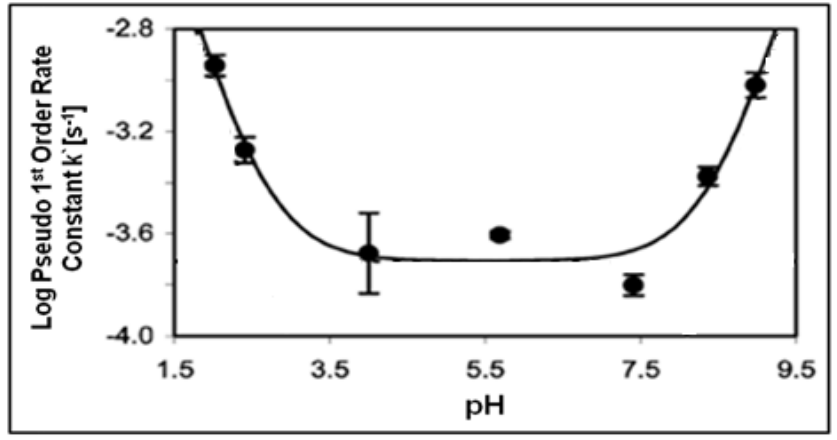
Figure 18. Pseudo-First-Order Rate Constant (k`) for bisphenol A cleavage to form p - isopropenylphenol as a function of system pH at 250 °C